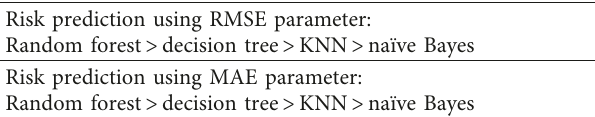
Table 4: Comparison of the order of all the techniques used. Risk prediction using RMSE parameter: Random forest > decision tree > KNN > na¨ıve Bayes Risk prediction using MAE parameter: